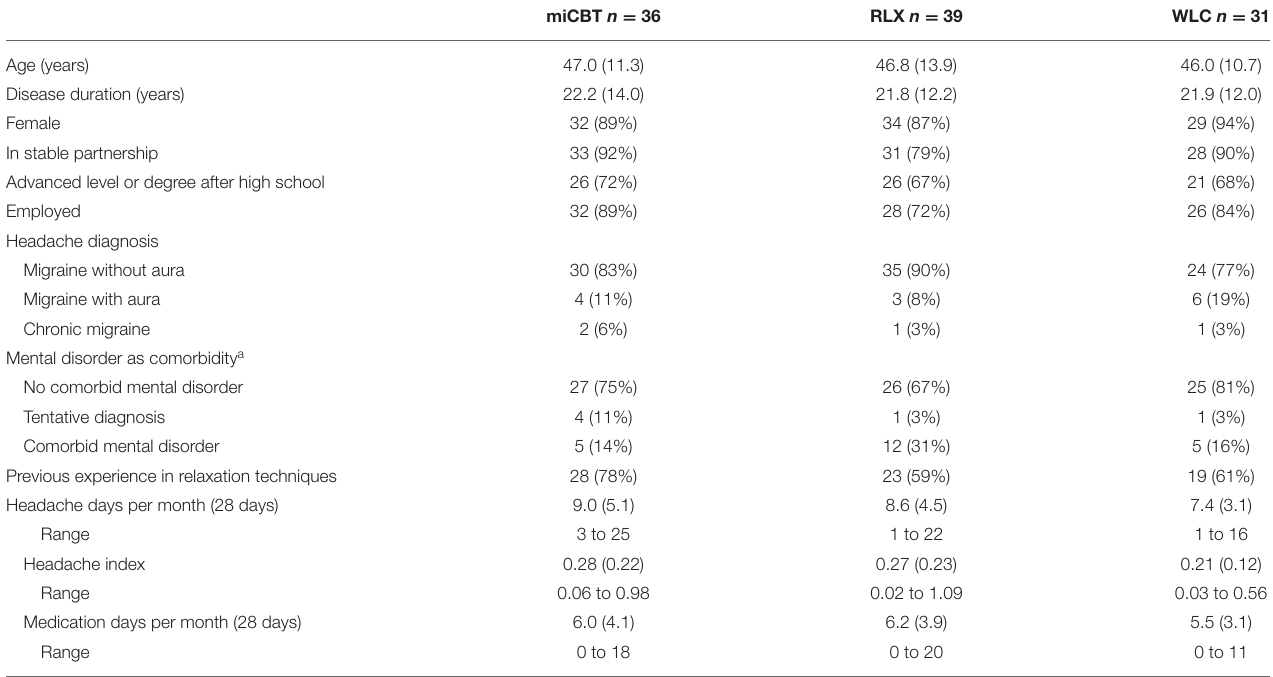
TABLE 1 | Baseline characteristics (intention-to-treat sample, N =